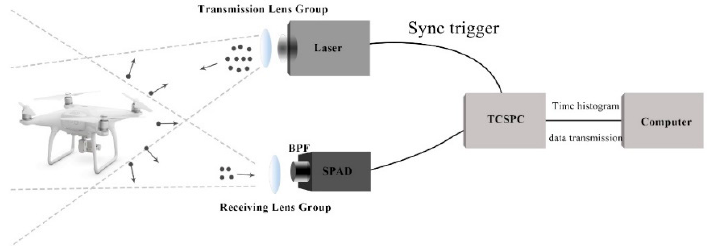
Figure 1. Schematic of the experimental setup for UAV detection. Moreover, a band-pass filter (BPF) is set in front of the lens to operate the photons reflected from the UAVs. The photons are then focused by a lens onto the SPAD.